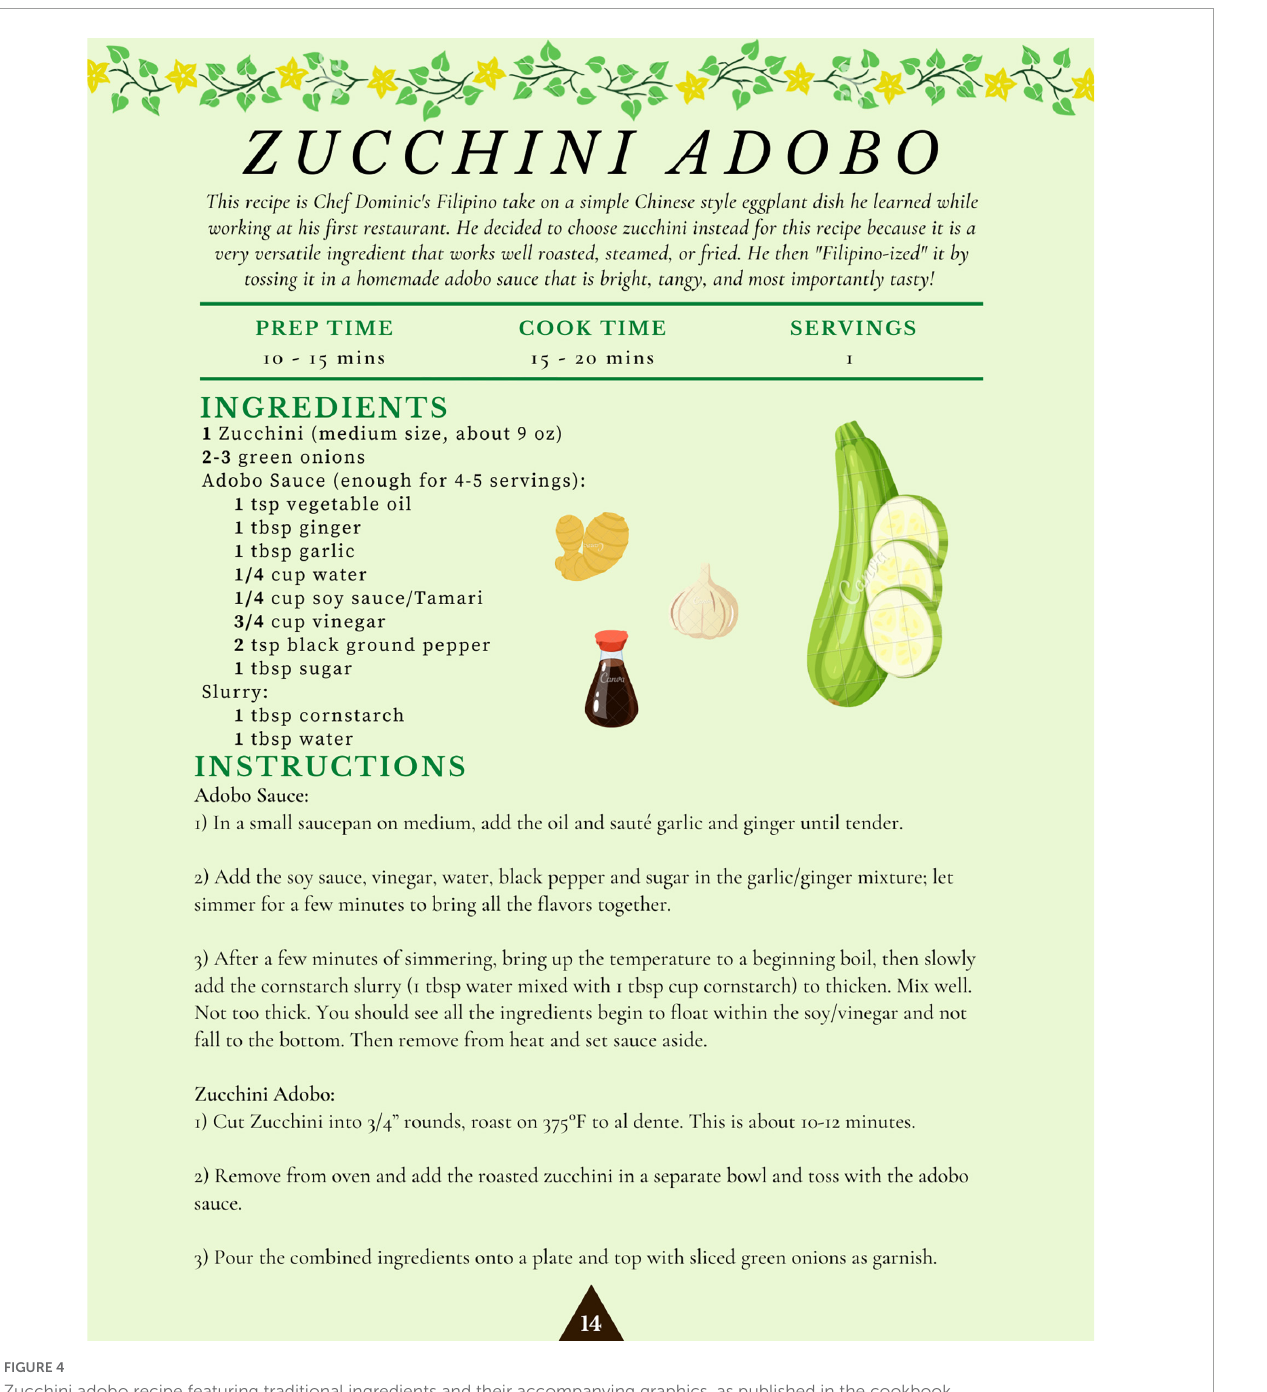
FIGURE4 Zucchini adobo recipe featuring traditional ingredients and their accompanying graphics, as published in the